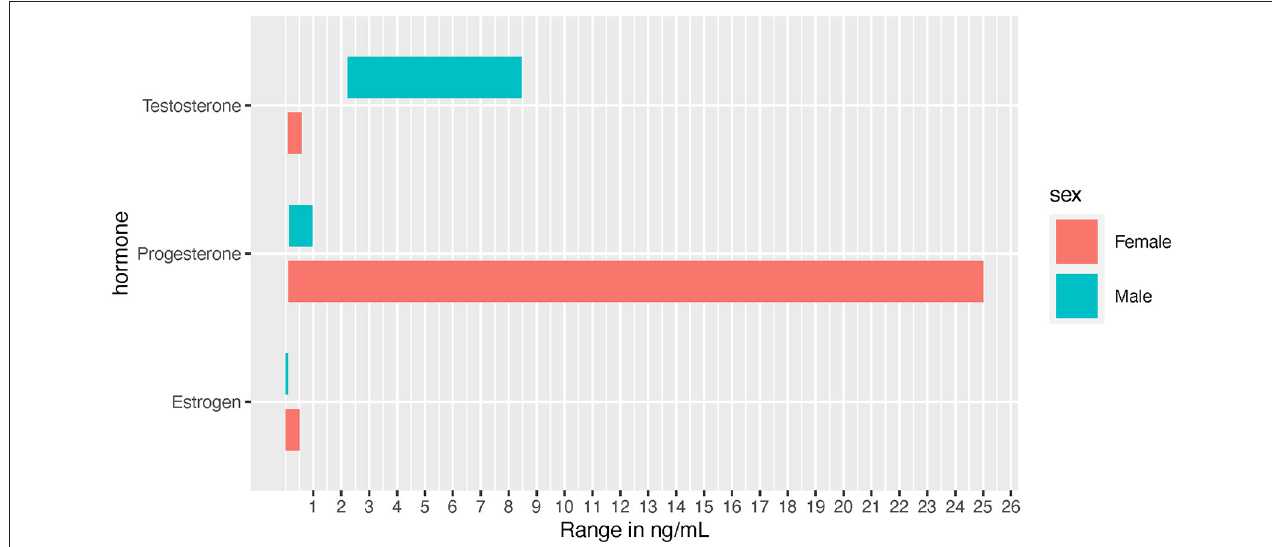
FIGURE 2 | Normal hormone concentration ranges depicted in ng/mL for visual comparison between the sexes. Female ranges depict the low to high values experienced throughout the menstrual